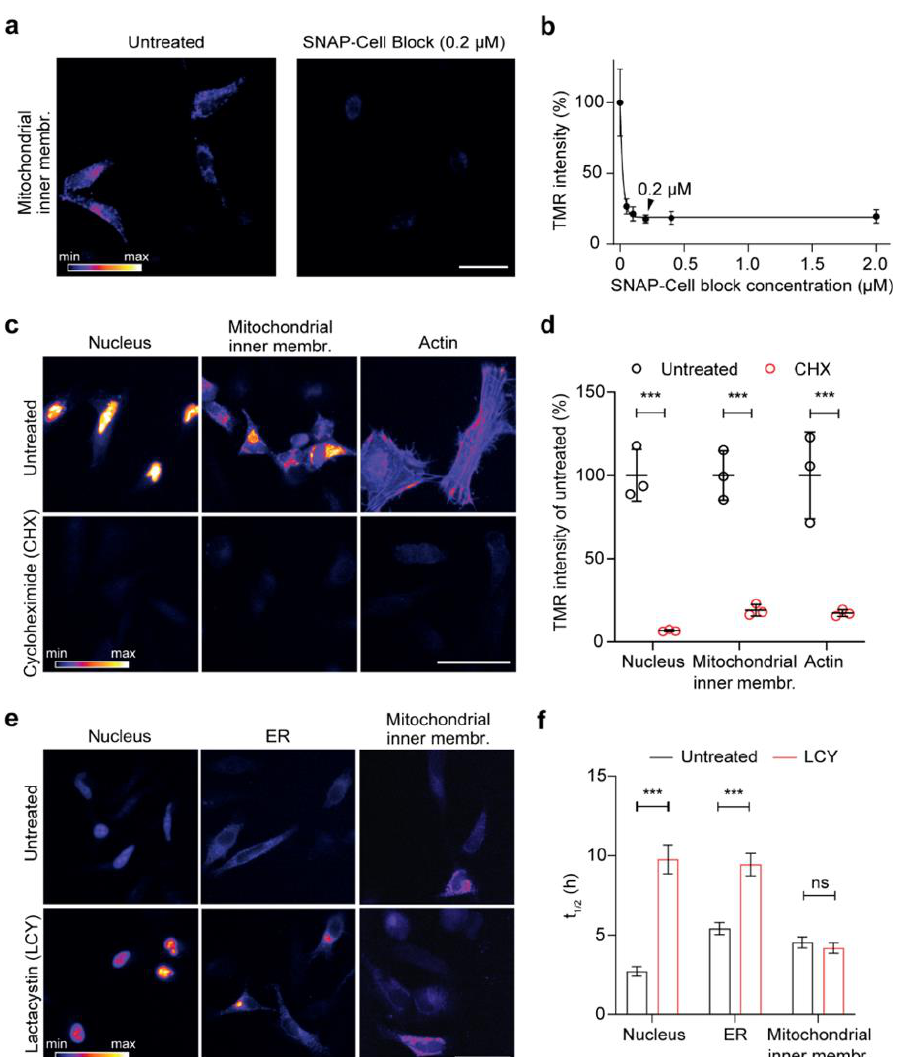
Figure 2. Testing the reliability of the assay for the optical analysis of protein turnover. ( a ) Representative images of cells expressing the mitochondrial inner membrane construct, either blocked with SNAP-Cell Block for 1 h or left untreated, followed by a 10 min pulse with SNAP-Cell TMR-BG. ( b ) Similar approach as in ( a ) with different concentrations of SNAP-Cell Block revealing a significant drop in TMR-BG intensity. The black arrowhead shows the selected concentration for further experiments (0.2 µM, representative image shown in ( a ). ( c ) Representative images of cells expressing NLS, mitochondrial inner membrane, and actin (Lifeact) constructs, blocked with SNAP-Cell Block for 1 h, followed by a 3-h pulse in the absence (untreated control) or the presence of cycloheximide (CHX, blocking protein synthesis). ( d ) Image intensity quantification in 75 images revealing a drop in SNAP-TMR-BG intensity after the use of CHX compared to untreated cells for all three conditions. ( e ) Block of proteasome function with lactacystin (LCY) and respective quantifications ( f ), showing that inhibiting proteasome function increases the lifetime of SNAP targeted to the nucleus or the ER, but does not affect its mitochondrial turnover. The images ( e ) correspond to the time point at 4 h after the beginning of the chase, while the quantifications in ( f ) correspond to the lifetime calculation, fitting entire chase curves as in Figure 3 (see below). Scale bars: 50 µm ( a , c ), 25 µm ( e ). The data are presented as mean ± 95% confidence interval (CI) ( b ) or mean ± standard error of the mean (SEM) ( d , f ), n = 3. Two-way analysis of variance (ANOVA), post hoc Bonferroni test ( d , f ), ns-not significant, *** p < 0.001.